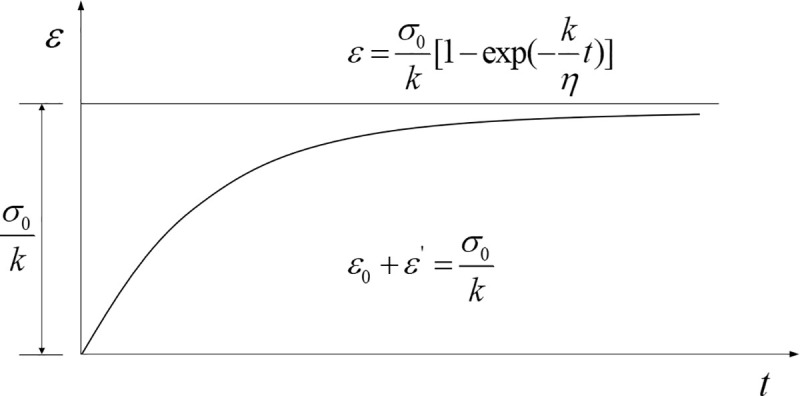
Kelvin creep curve.